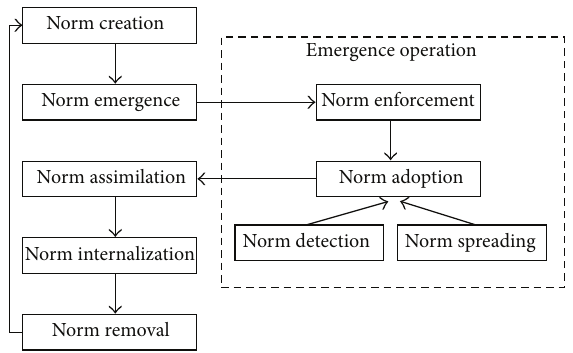
Figure 14: A proposed norm’s life cycle